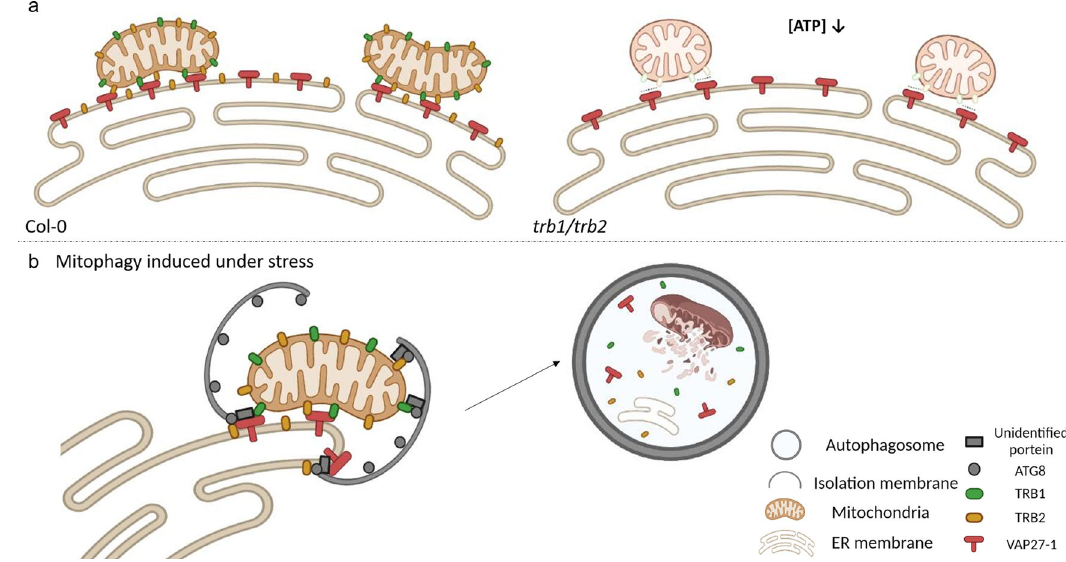
Fig.8|ProposedmodelforTRB1-VAP27mediatedMitochondria-ERinteraction and mitophagy. a Under normal conditions, mitochondria are tethered to the ER throughthe TRB1-VAP27 complex atEMCSs;this link is essentialformitochondrial function (e.g., movement, morphology, and energy metabolism). b TRB1